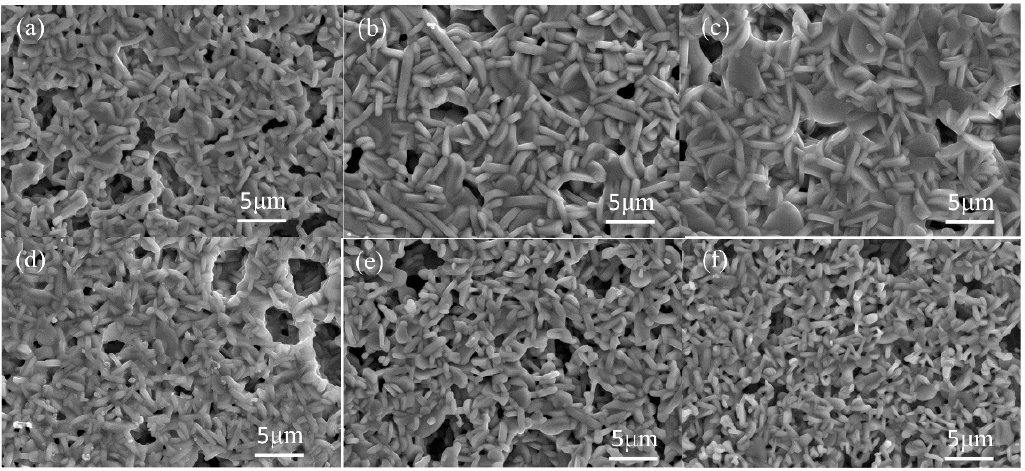
Figure 2. SEM images of LNT solid solutions with Ti 20 mol % at 1373 K for 30 min under various air pressures, ( a ) 0.30 MPa, ( b ) 0.35 MPa, ( c ) 0.40 MPa, ( d ) 0.45 MPa, ( e ) 0.50 MPa, and ( f ) 0.60 MPa.